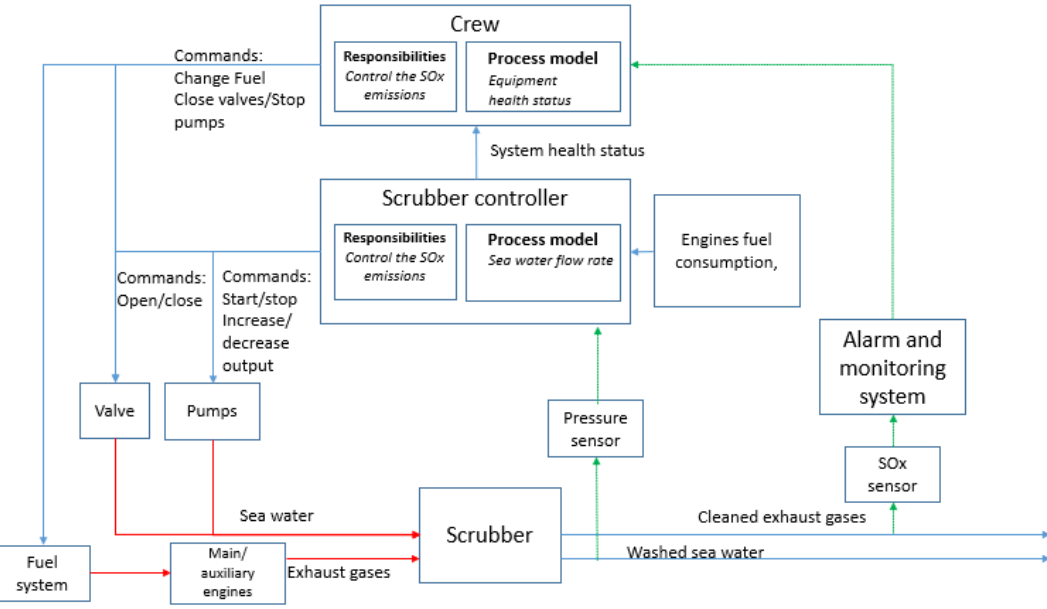
Figure 8. Scrubber control structure.